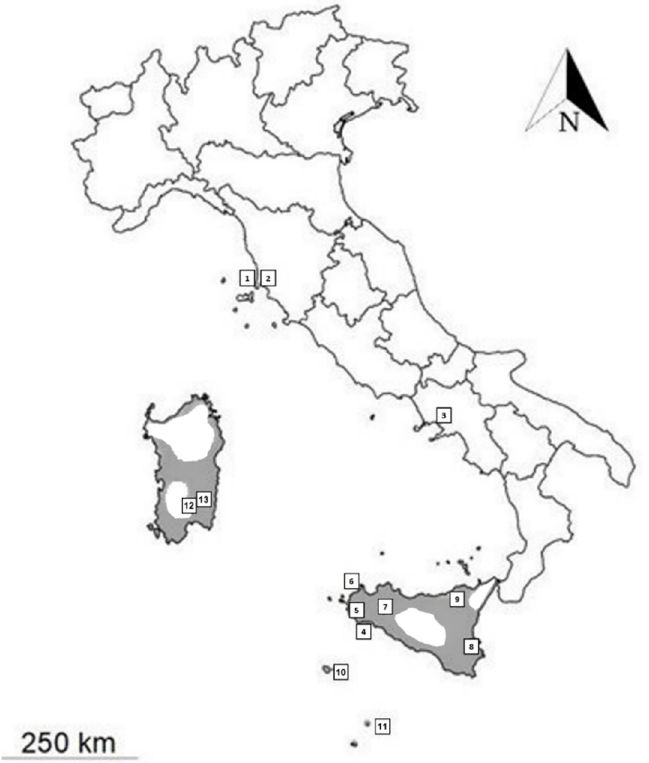
Figure 2. Updated distribution (gray areas) of the ocellated skink in Italy and sites of sample origin (from [10], modified): (1) Piombino; (2) Torre Mozza; (3) Portici; (4) Triscina di Selinunte; (5) Mazara del Vallo; (6) Riserva dello Zingaro; (7) Ficuzza; (8) Siracusa; (9) Rocche del Crasto; (10) Pantelleria island; (11) Linosa Island; (12) Serdiana; (13) Dolianova. One sample was analyzed from each place.